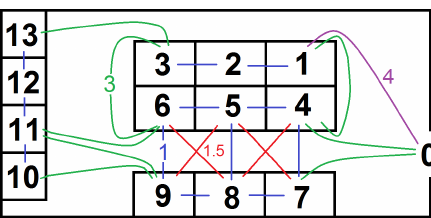
Figure 1. Sample warehouse structure used to explain the data format and problem encoding. Distances between neighboring locations: in blue the distances of 1 unit, in red of 1.5 unit, in green of 3 units, in violet of 4